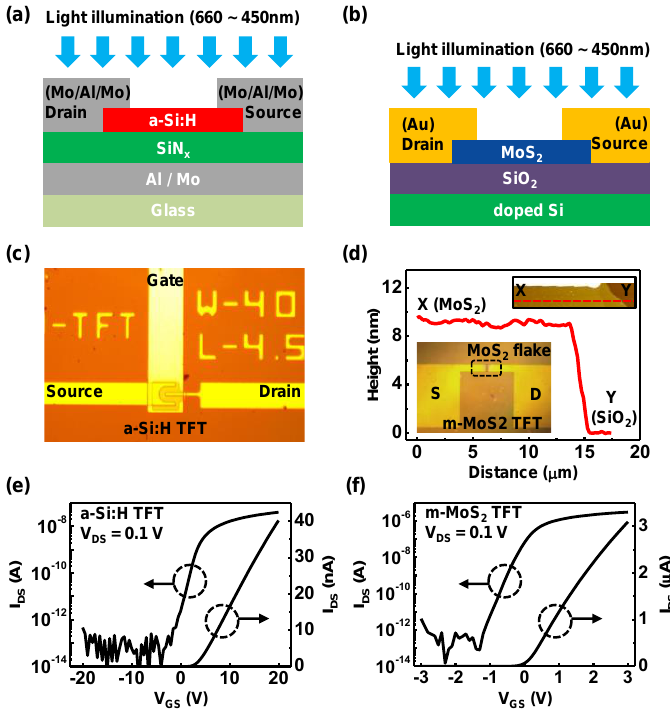
Figure 1. Cross-sectional views of ( a ) an a-Si:H TFT and ( b ) a m-MoS 2 TFT under illumination. Optical microscope images of ( c ) an implemented a-Si:H TFT. ( d ) Topographical cross-sectional profile along the dashed line indicates in the atomic force a microscope image of exfoliated MoS 2 layers, X on thermal oxide and Y in the FETs. X and Y in the inset (right top) denote the location of an oxide (SiO 2 ) and a MoS 2 layer, respectively. Inset (left bottom) shows optical microscope images of the implemented m-MoS 2 TFT. The channel width-to-length ratio (W/L) was 40/4.5 μm for the a-Si:H TFT and 30/10 μm for the m-MoS 2 TFT. Transfer characteristics of ( e ) a-Si:H TFT and ( f ) m-MoS 2 TFT in linear and log scale measured at V DS = 0.1 V.